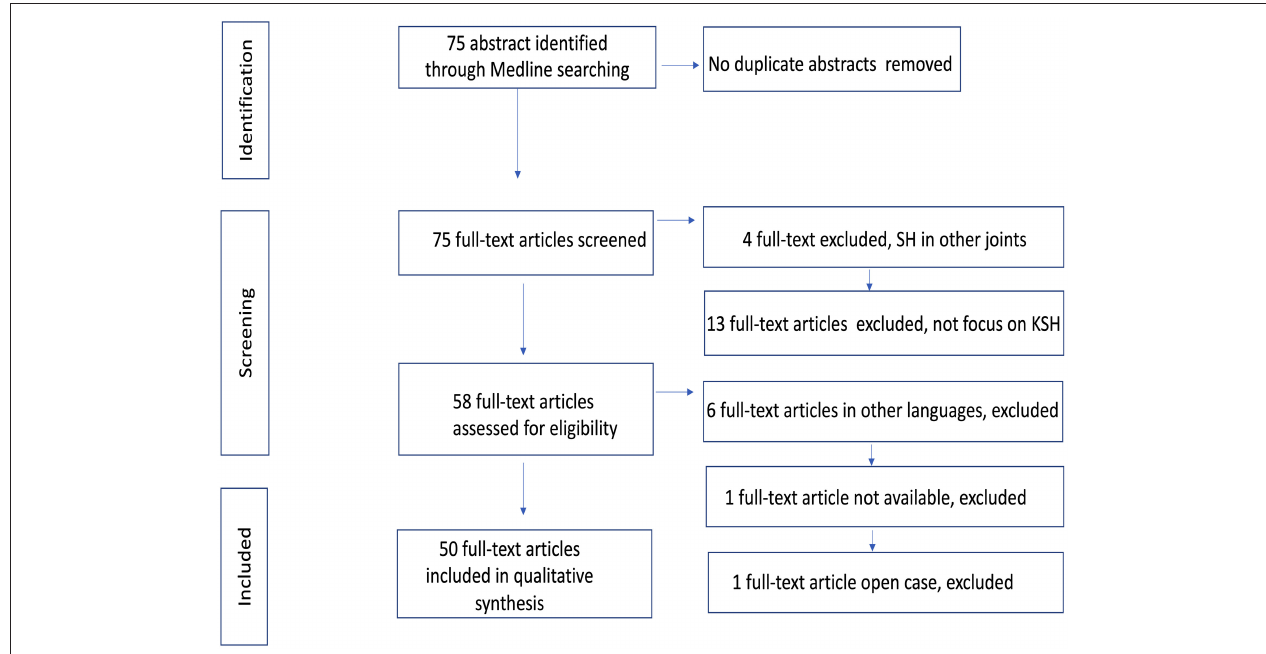
FIGURE 9 | Flow chart of information through the different phases of the systematic review.